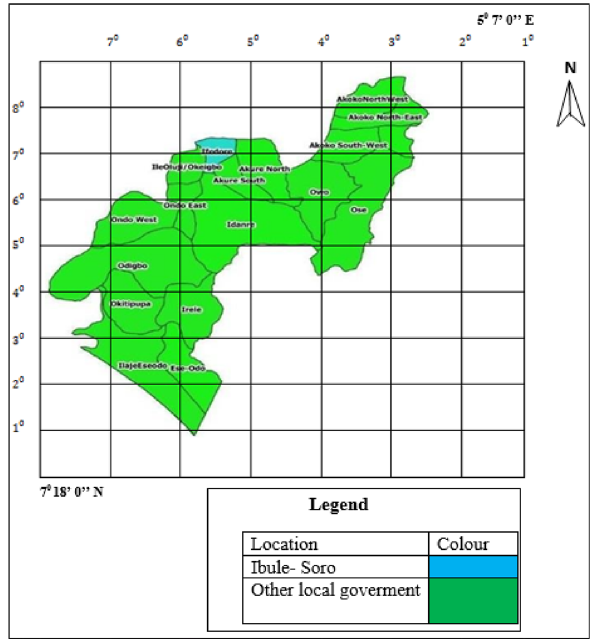
Fig. 1 Map of Ondo State showing location of study area. Modified after Folayan et al.